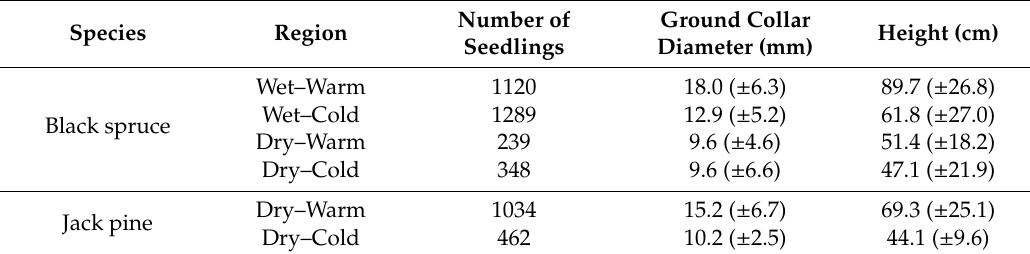
Table 1. Number of jack pine and black spruce seedlings in the four regions, with their corresponding height and ground collar diameter at the end of their third growing